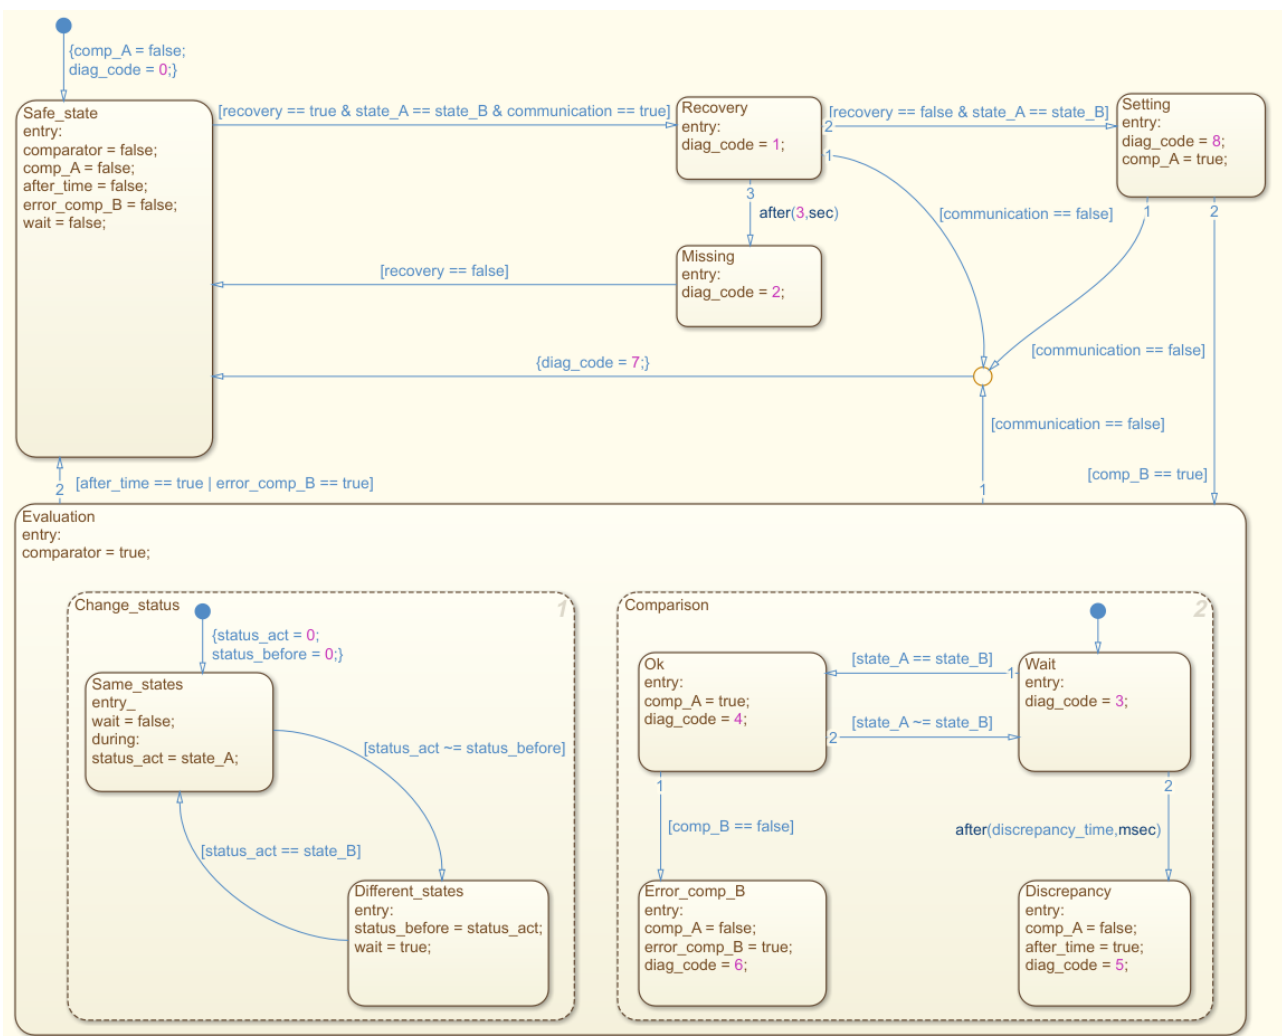
Figure 5. Comparator state diagram.